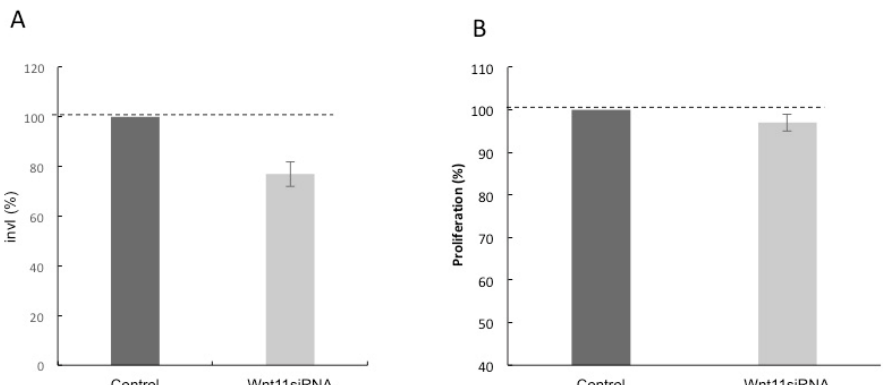
Figure 3. Functional evidence for Wnt-11-induced reduction of Matrigel invasion on Panc-1 cell lines. Panc-1 cells were transfected for 72 hours with control or Wnt-11 siRNAs, plated on Matrigel coated transwell filters and the extent of invasion determined after 16 hours. ( A ) Wnt-11 siRNA decreased invasion by 23% ( n = 3; p = 0.02). The results are plotted as Invasion Index (InvI, %), which is the percentage of invaded cells compared to the total number of cells seeded. ( B ) The total cell number / proliferation did not change during the course of the experiment ( n = 3; p > 0.05). All data were analysed as means ± standard